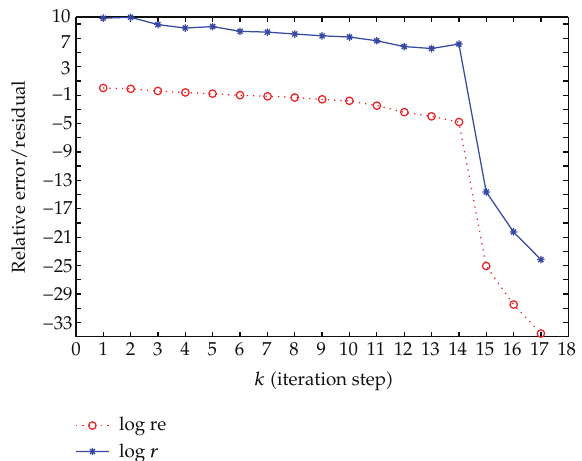
Figure 2: The relative error of the solution and the residual for Example 4.1 with X 1 (cid:2) 0